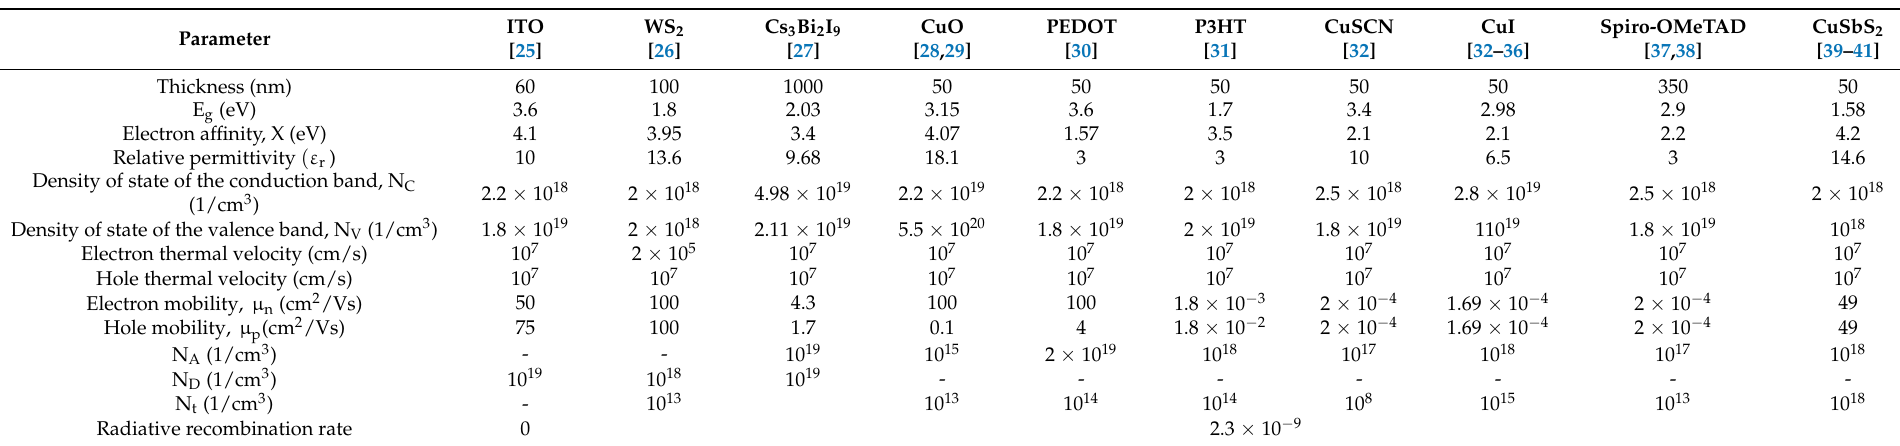
Table 1. Input parameters for electron transport material, absorber material, and different hole transport